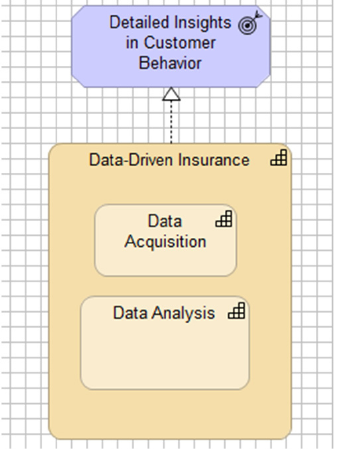
Figure 9. Using the resulting slice for a new EA artifact development. Table 2. The number of components, relations, and views before and after slicing.